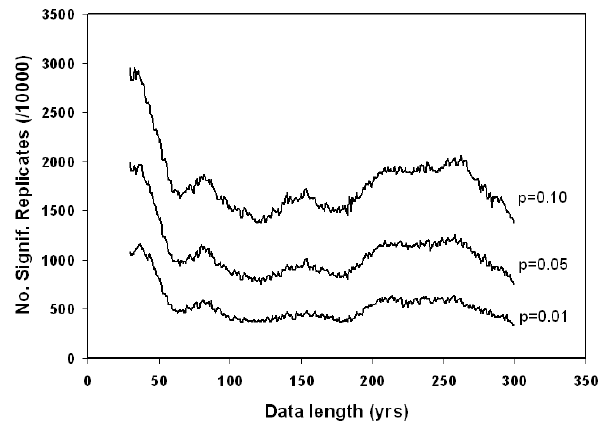
Figure 7. Number of identified significant trends from randomly sampled Monte Carlo replicates at p=0.10, p=0.05 and p=0.01.